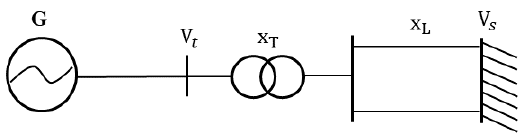
Figure 1. The SG connection to an SMIB model.